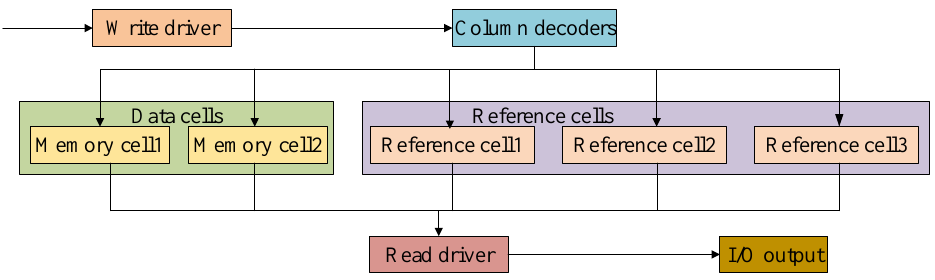
Figure 7. A schematic of the multilevel phase change memory system.